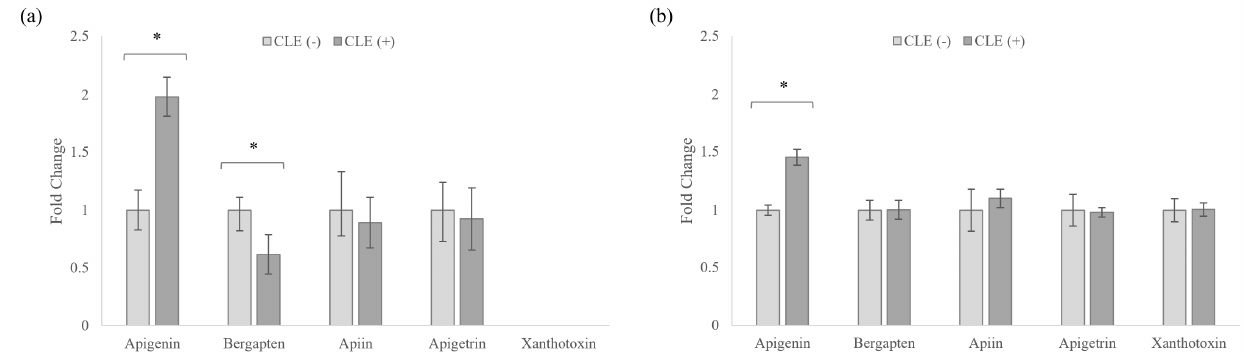
Figure 6. Fold change intensity variations in celery leaf bioactive metabolites in ( a ) cells; ( b ) culture medium. (+) and ( − ) refer to LPS-stimulated and unstimulated samples respectively. * indicates p < 0.05.